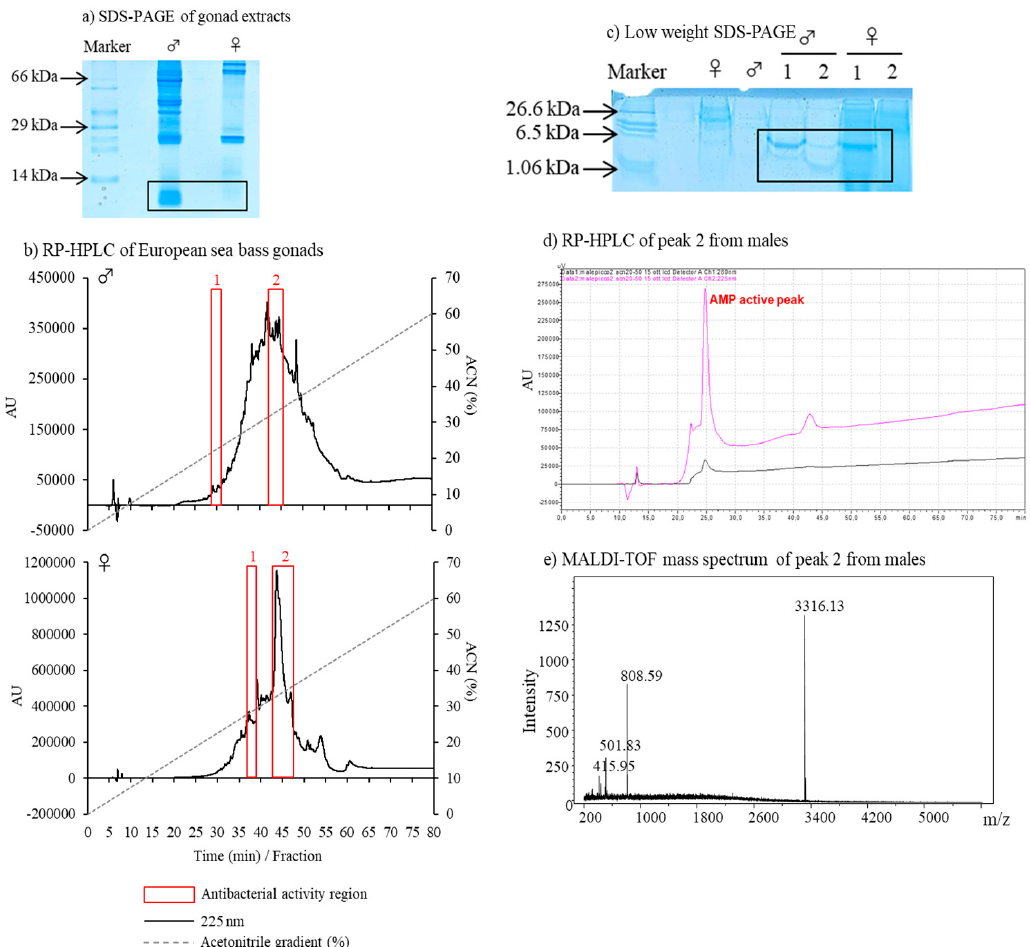
Figure 2. Determination of antimicrobial peptides (AMPs) from adult European sea bass gonads. ( a ) for sodium dodecyl sulfate polyacrylamide gel electrophoresis (SDS-PAGE) of whole testis and ovary homogenates. ( b ) Peptidic profile of testis and ovary by reverse phase high-performance liquid chromatography (RP-HPLC) and bactericidal activity. ( c ) Low weight SDS-PAGE of ovary and testis homogenates and peptides purified by RP-HPLC with antibacterial activity. ( d ) Peak 2 of testis purified by RP-HPLC with antibacterial activity. ( e ) Matrix assisted laser desorption ionization-time of flight (MALDI-TOF) mass spectrometry mass spectrum of peak 2 of testis. Black squares: region of interest; red squares: region with antibacterial function; ♂ : male; ♀ : female; ACN: acetonitrile; AU: absorption units.